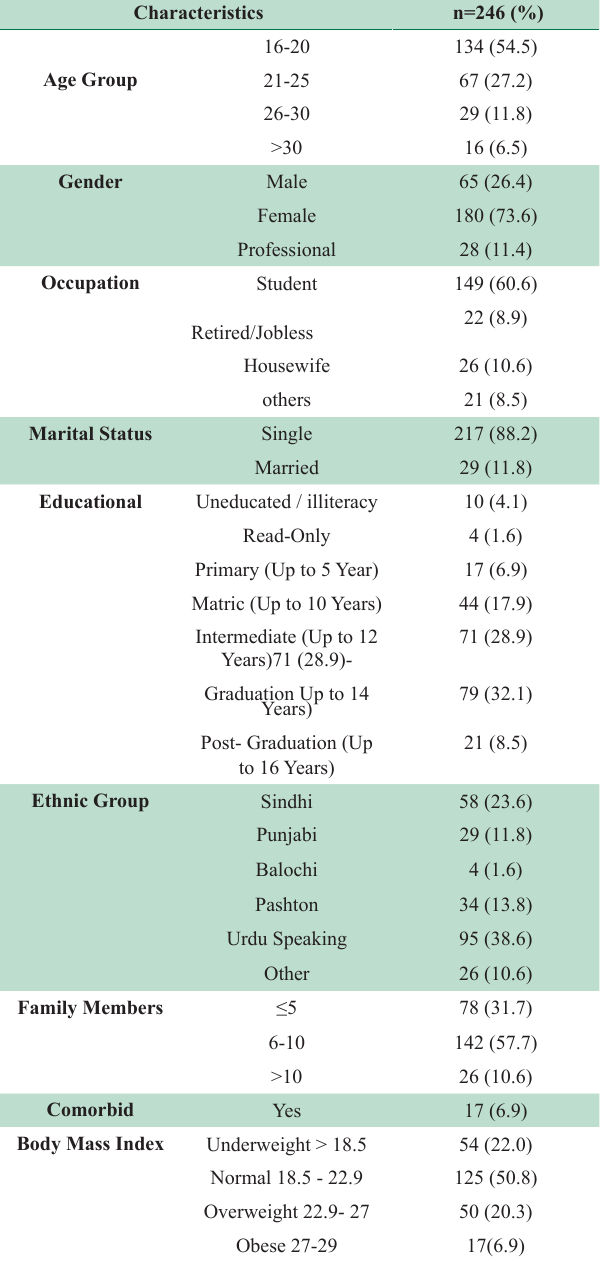
Table-II: Baseline Demographics of Studied population n (%).